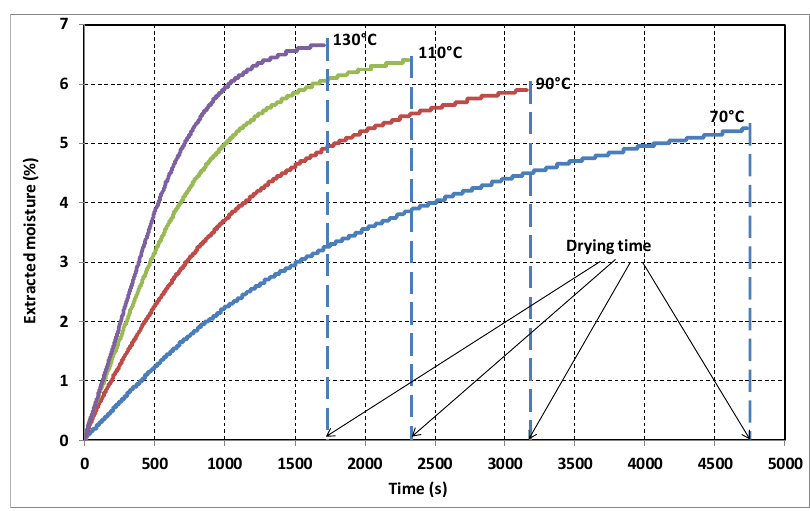
Figure 2. Influence of temperature on the drying time of a weight of 10 g.